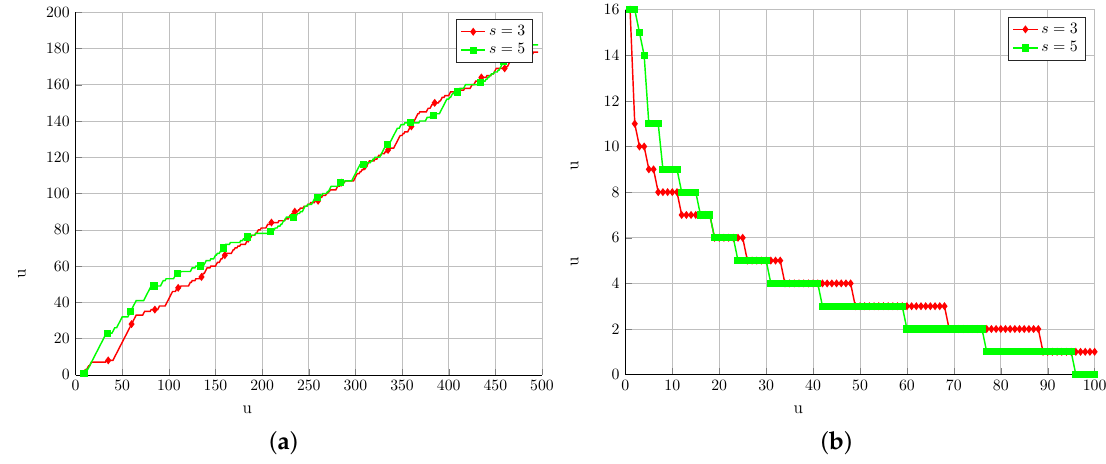
Figure 7. Illustration for the Hanoi water network. ( a ) Number of regions versus number of iterations; ( b ) Number of occurrences for a region (sorted in descending order, clipped at the 100-th